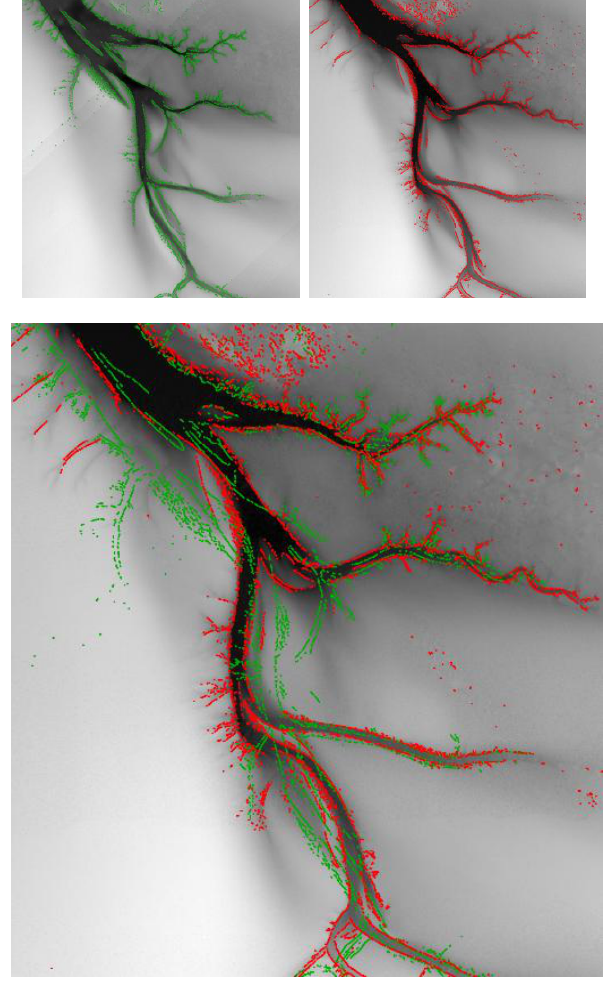
Figure 4. DTM of 2010 (top left) and DTM 2012 (top right, bottom) with channel edges for 2010 (green) and 2012